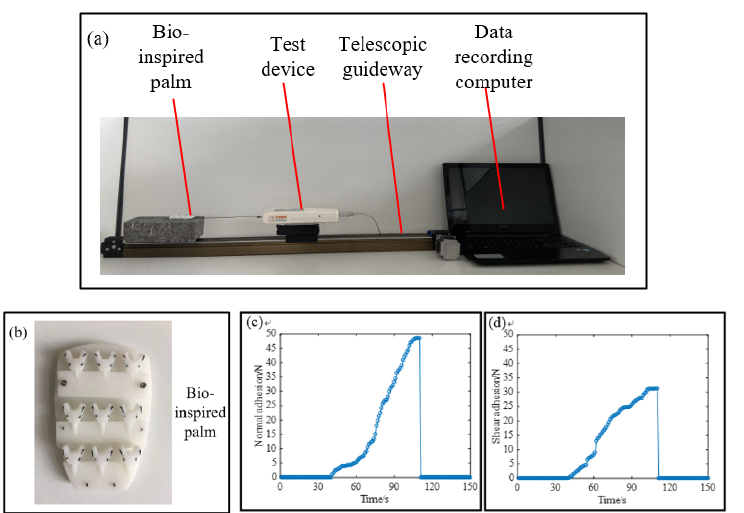
Figure 7. The adhesion force of the bionic palm. ( a ) A measuring platform to measure the adhere force. ( b ) The bionic palm with various bionic spines. ( c ) The normal adhesion force of this bionic palm. ( d ) The shear adhesion force of this bionic palm.